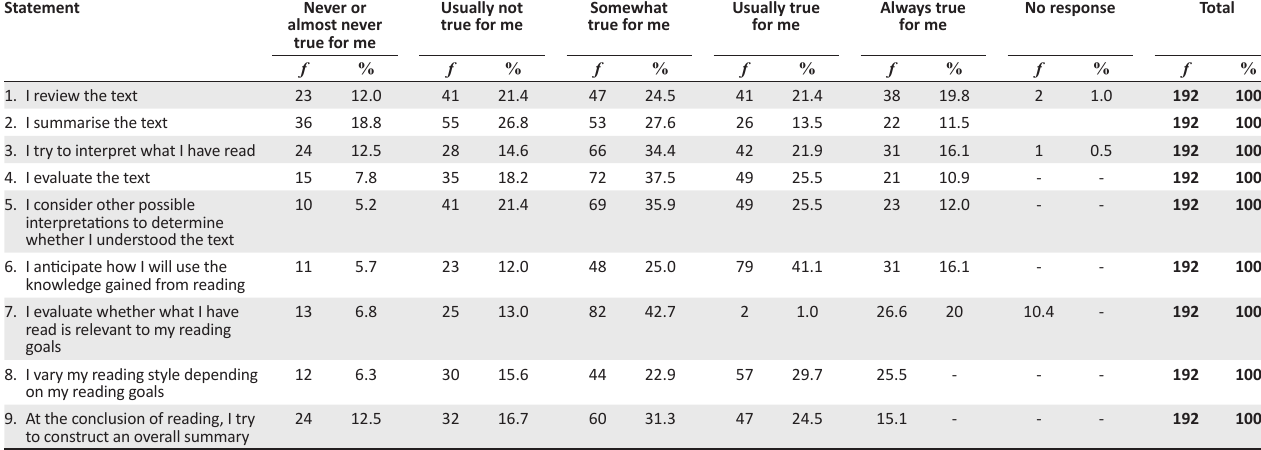
TABLE 3: Post-reading